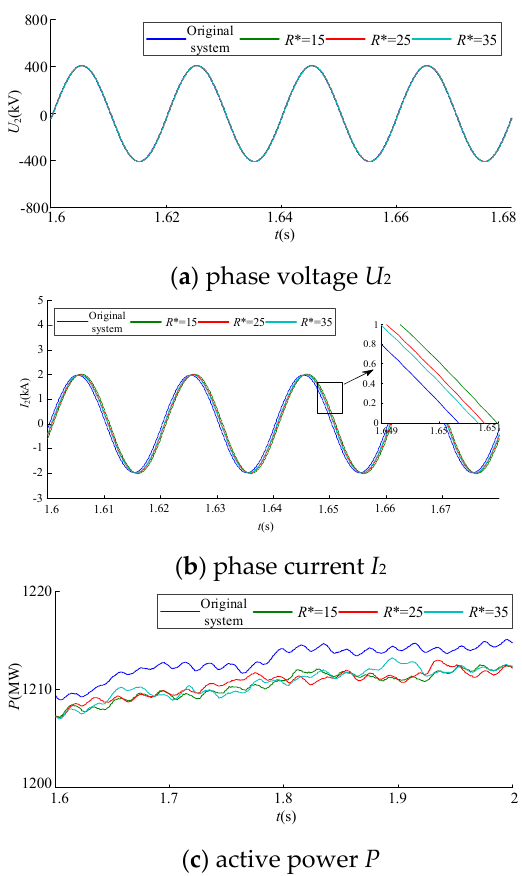
Figure 10. Simulation results comparison for different values of R* . ( a ) phase voltage U 2 , ( b ) phase current I 2 , ( c ) active power P.